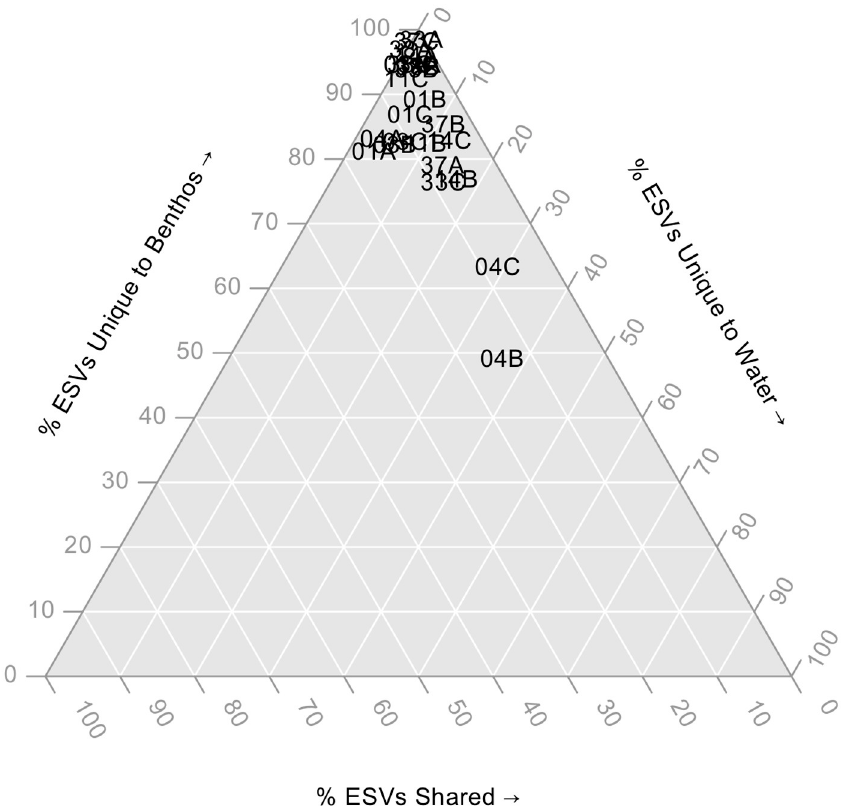
Fig 2. Few arthropod ESVs are shared among benthic and water samples. The ternary plot shows the proportion of ESVs unique to benthos samples, unique to water samples, or shared. Sample names are shown directly on the plot. Results are based on normalized